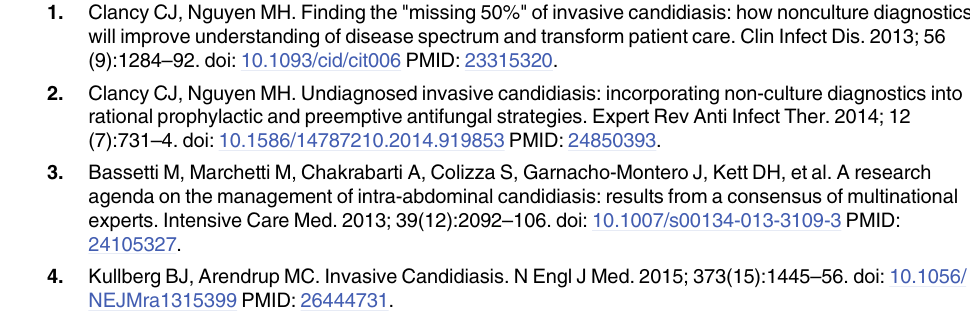
S2 Table. Clinical characteristics of patients with culture-proven recurrent or persistent intra-abdominal